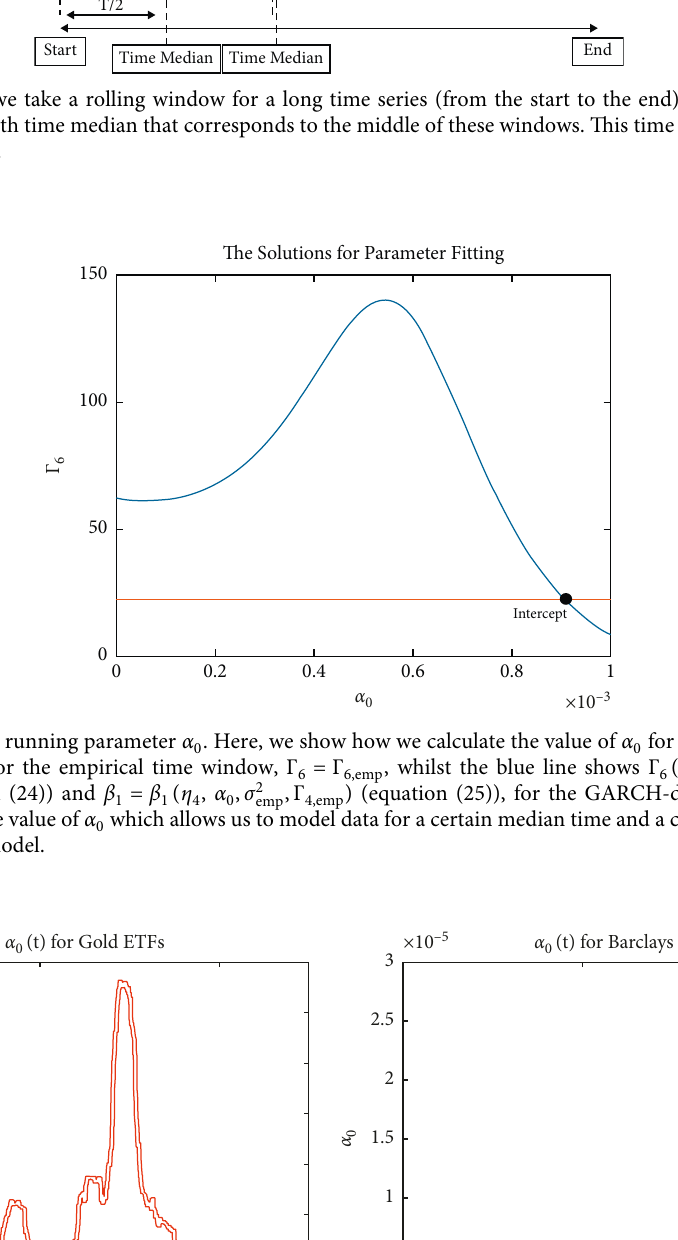
Figure 9: The evolution of the GARCH parameter α for the period 2000–2009. The two plotted curves provide the upper and lower bounds 0 of the confidence interval for α estimated by the method described within Appendix A, for Gold ETFs (a) and Barclays Bank (b). In all 0 prior to the financial crisis of 2008, followed by a very large decrease either before or during figures, we see a large increase in the value of α 0 the crisis